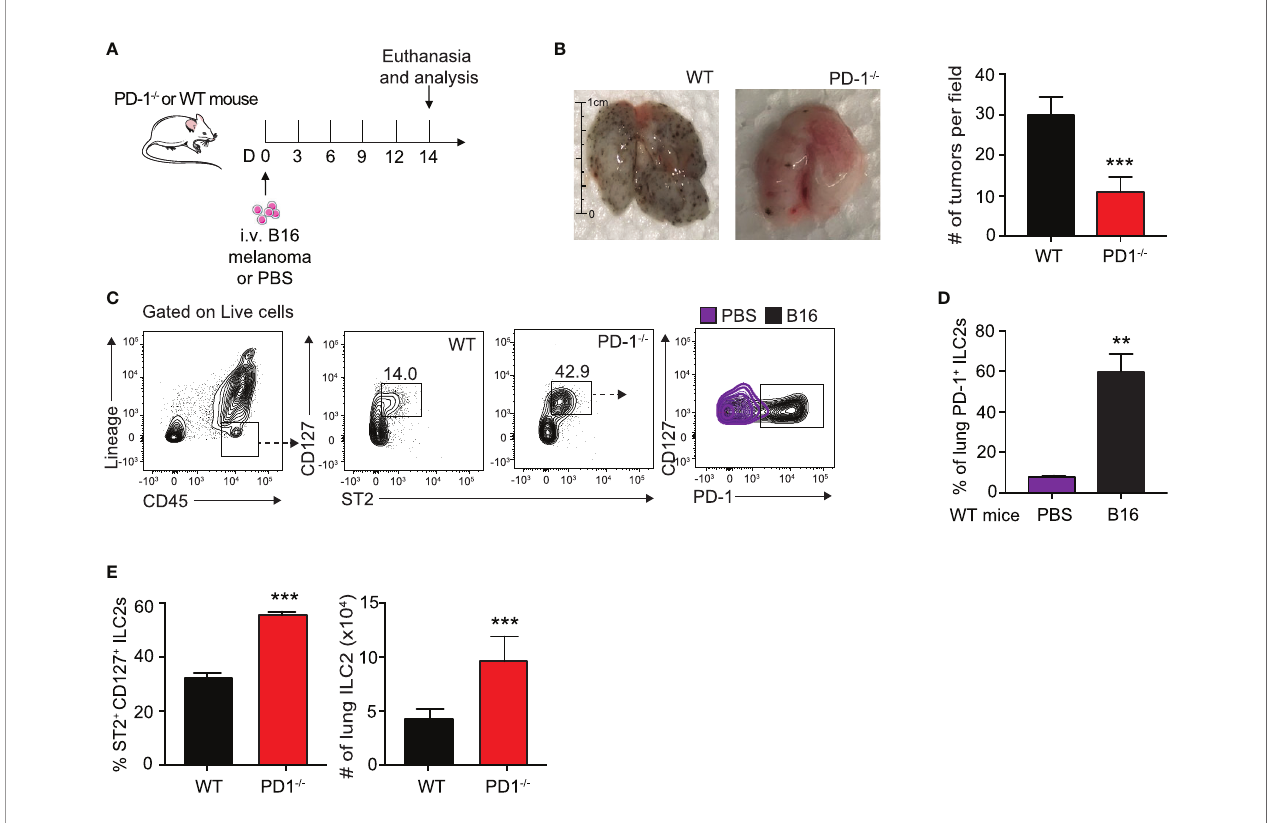
FIGURE 1 | B16 melanoma induces PD-1 expression on pulmonary ILC2s. (A) A cohort of PD-1 -/- or WT mice was given an intravenous injection of B16 melanoma cells (2.5 x 10 5 ) on day 0. On day 14 tumor cell colonies on the lung surface were counted per fi eld (B) and presented with corresponding quanti fi cation. (C) Lungs were then digested and ILC2s were identi fi ed and quanti fi ed. Representative gating strategy identifying lung ILC2s and PD-1 expression by fl ow cytometry. (D) Percentage of ILC2s expressing PD-1 in lungs of WT BALB/cByJ mice intravenously injected with B16 melanoma or PBS (E) Percentage and total number of ILC2s in the lungs of PD-1 -/- or WT mice with B16 melanoma. Error bars are the mean±SEM. Data are representative of 3 individual experiments with n=5. Student ’ s t-test, **p<0.01,